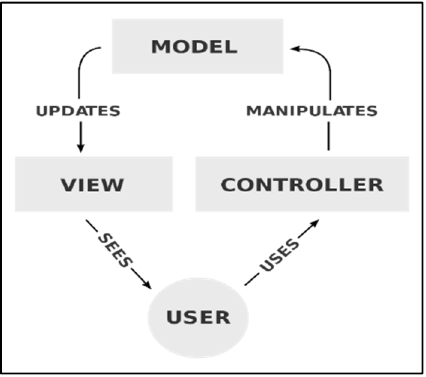
Figure 6. MVC Model.